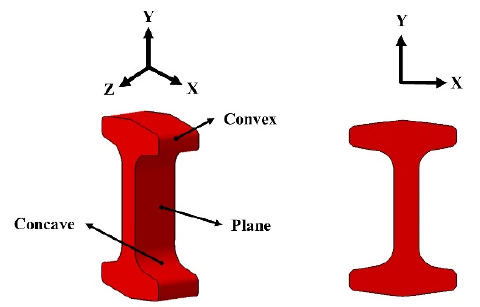
Figure 4. A schematic diagram of the special ‐ shaped hot forging of 300 M steel.